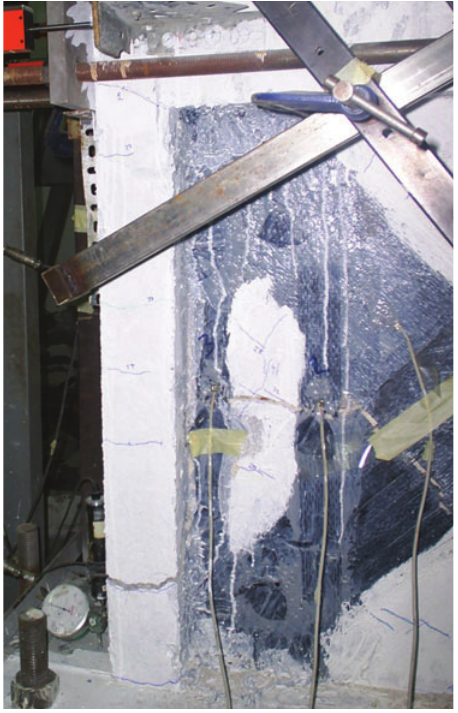
Figure 10 Damage state of specimen SA1.0-CV at 0.9 % drift level.